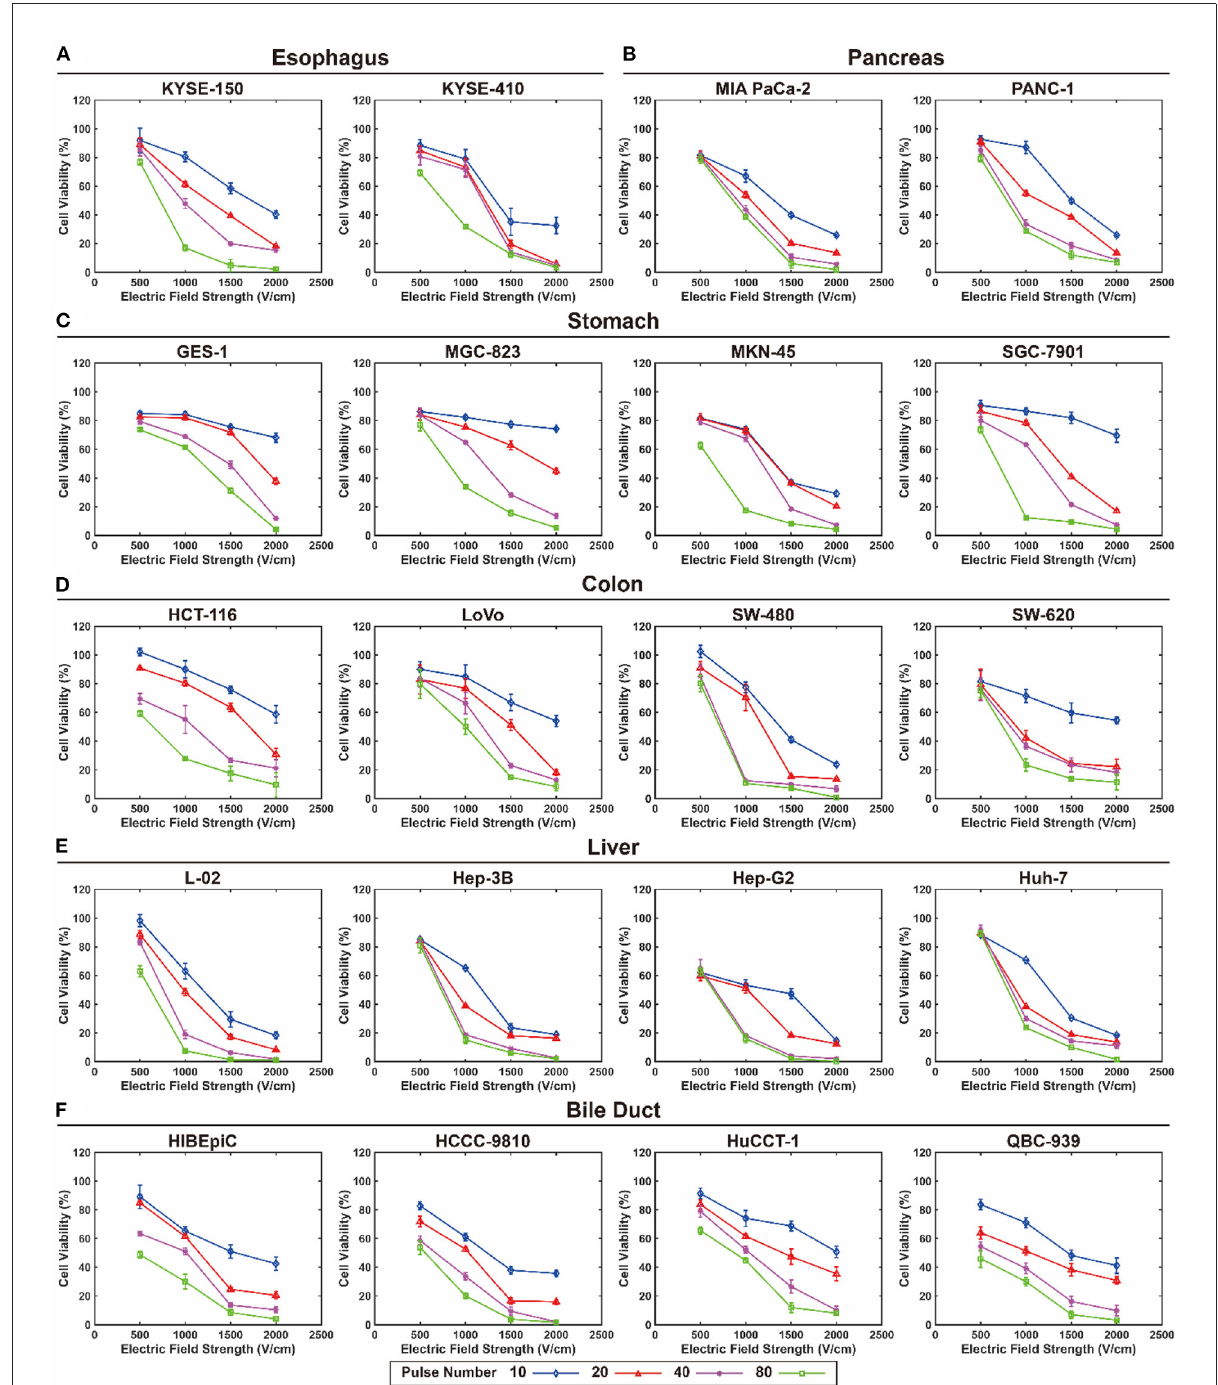
FIGURE1 Viability of each cell line exposed to electroporation pulses with 100 µ s pulse duration under various pulse numbers and electric field strengths. (A) Esophagus, (B) pancreas, (C) stomach, (D) colon, (E) liver, and (F) bile duct.